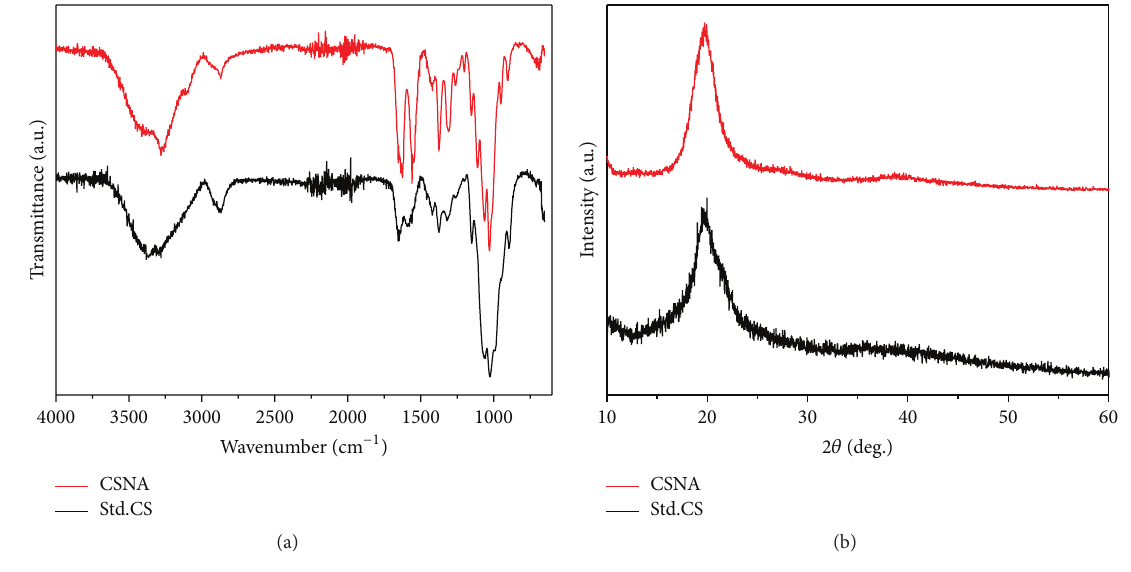
Figure 2: (a) Comparative FTIR spectra and (b) XRD pattern of CSNA and Std.CS.